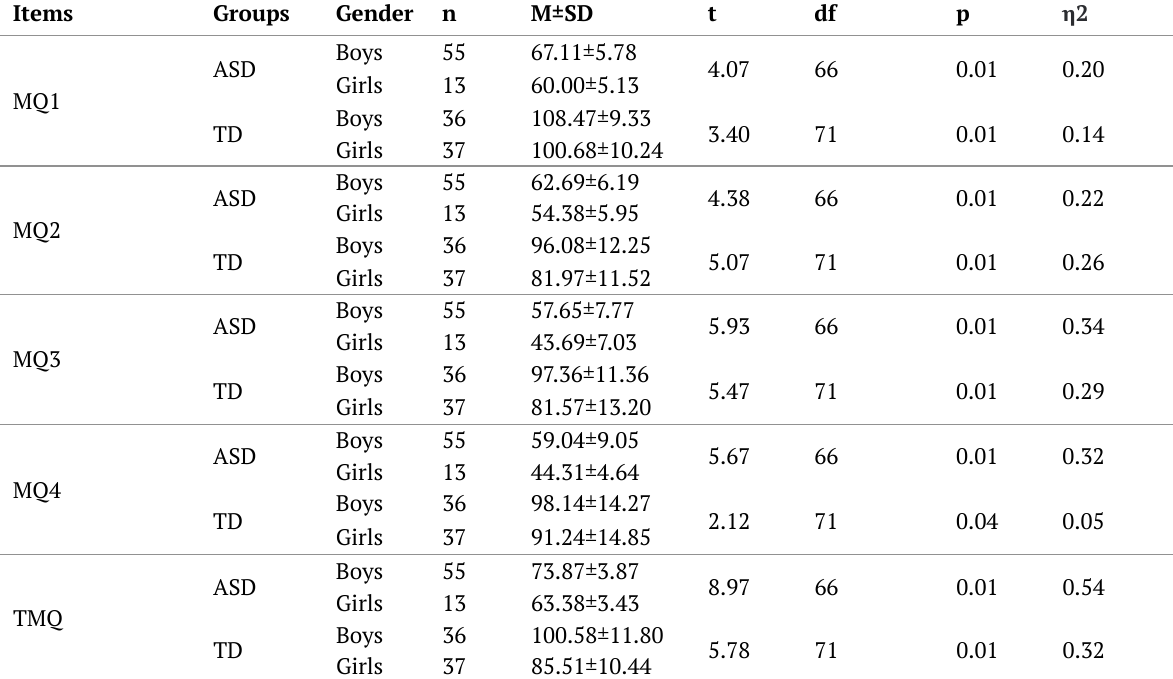
Table 3. Results of Comparing the ASD/TD Groups Measurement Values According to Gender